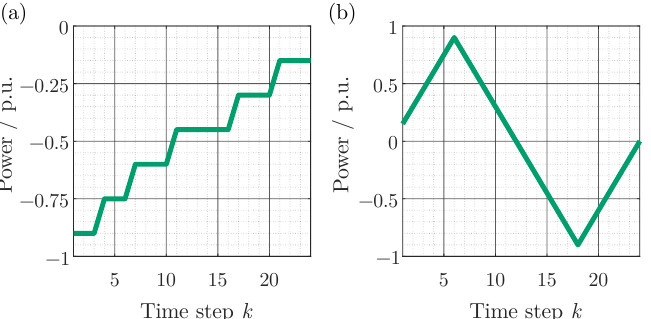
Figure 2. Unidirectional load profile I ( a ) and bidirectional load profile II ( b ). Powers are normalized to P LP